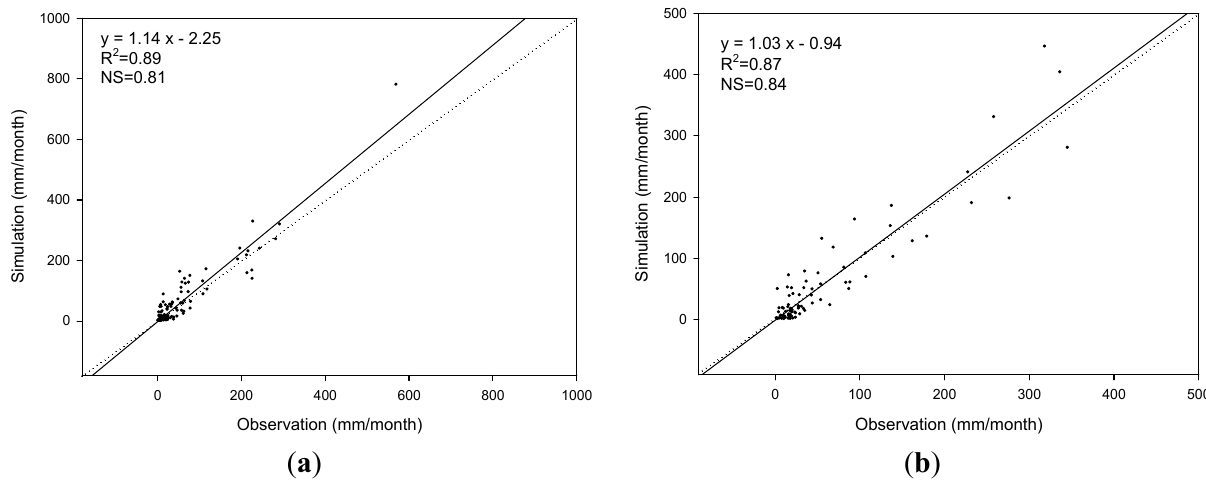
Figure 6. Scatter plots of monthly simulated and observed runoff for calibration ( a ) and validation ( b ).